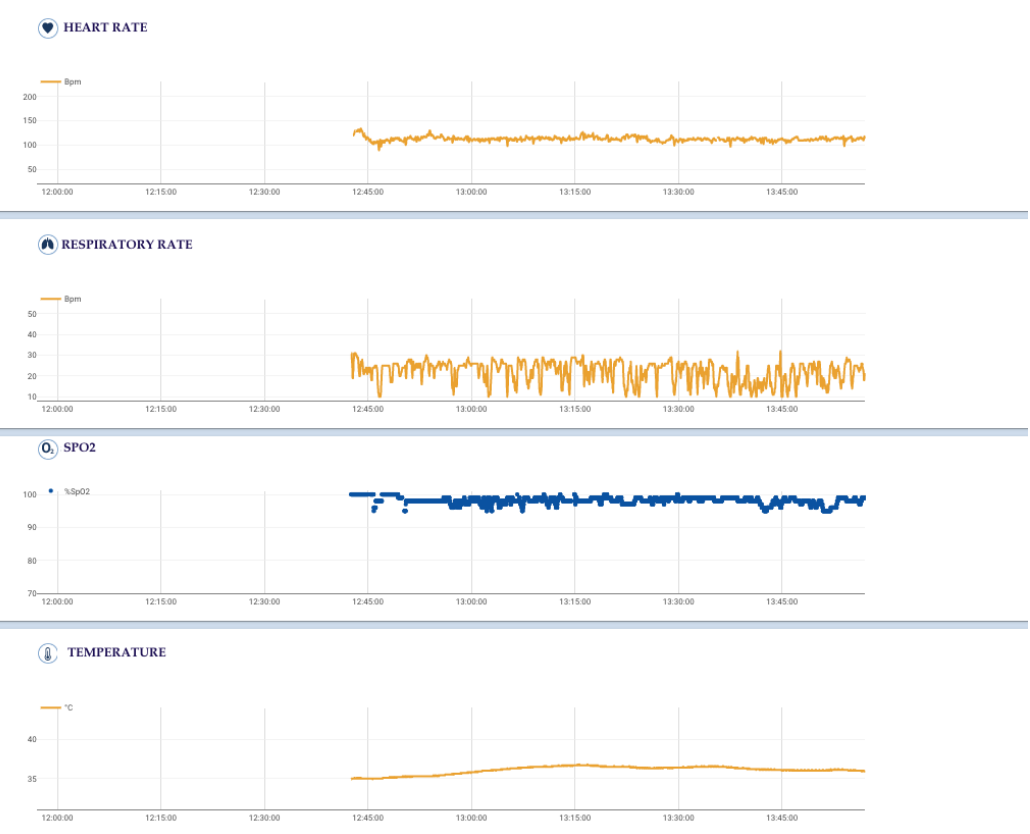
Figure 2. Physiological parameters, each with its own sampling frequency, acquired by sensorized garment Healer R2 and elaborated by Healer software of a single intervention (start time h: 12:38, end time h 14:00).